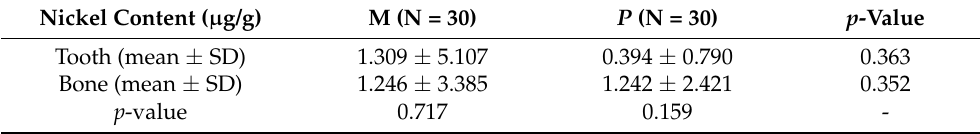
Table 12. Nickel content in tested samples taken from patients differing in place of residence.